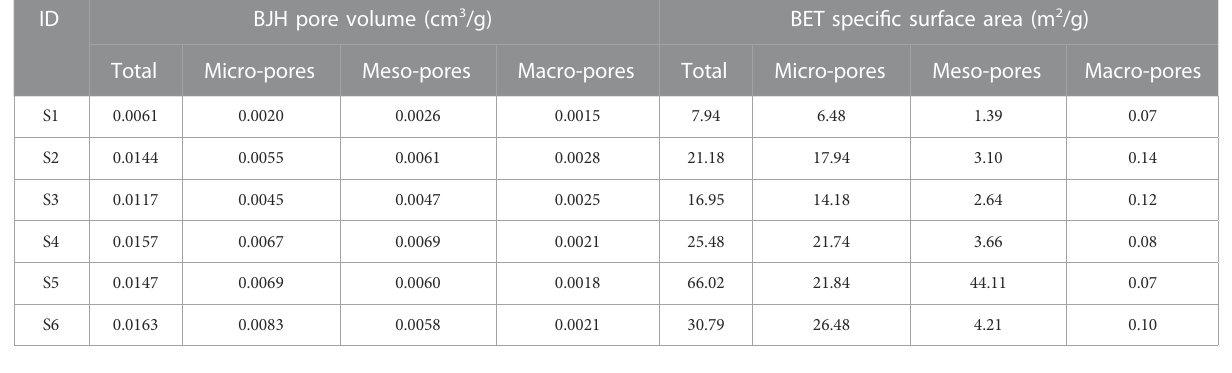
TABLE 2 Pore structure parameters on the selected shales identi fi ed by the LT-N 2 GA measurement.